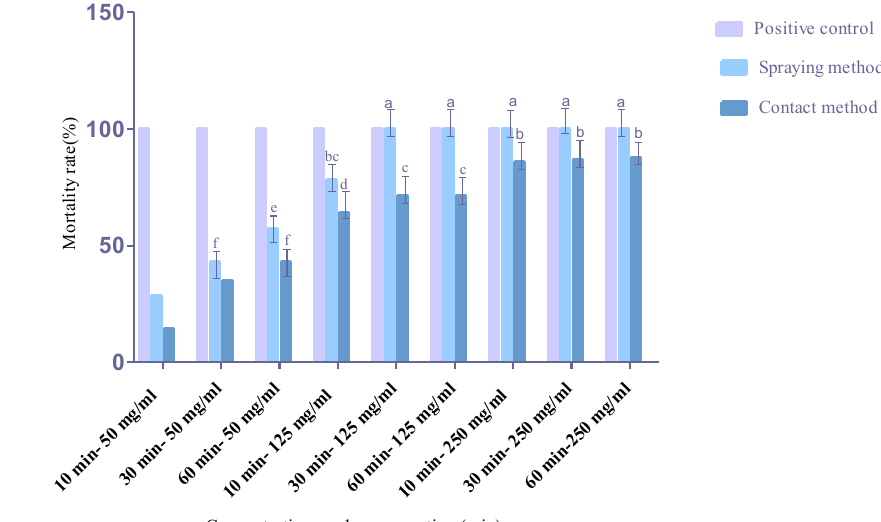
Fig. 3. Acaricidal effects of different concentrations of the Zn NPs against Hyalomma spp. after various exposure